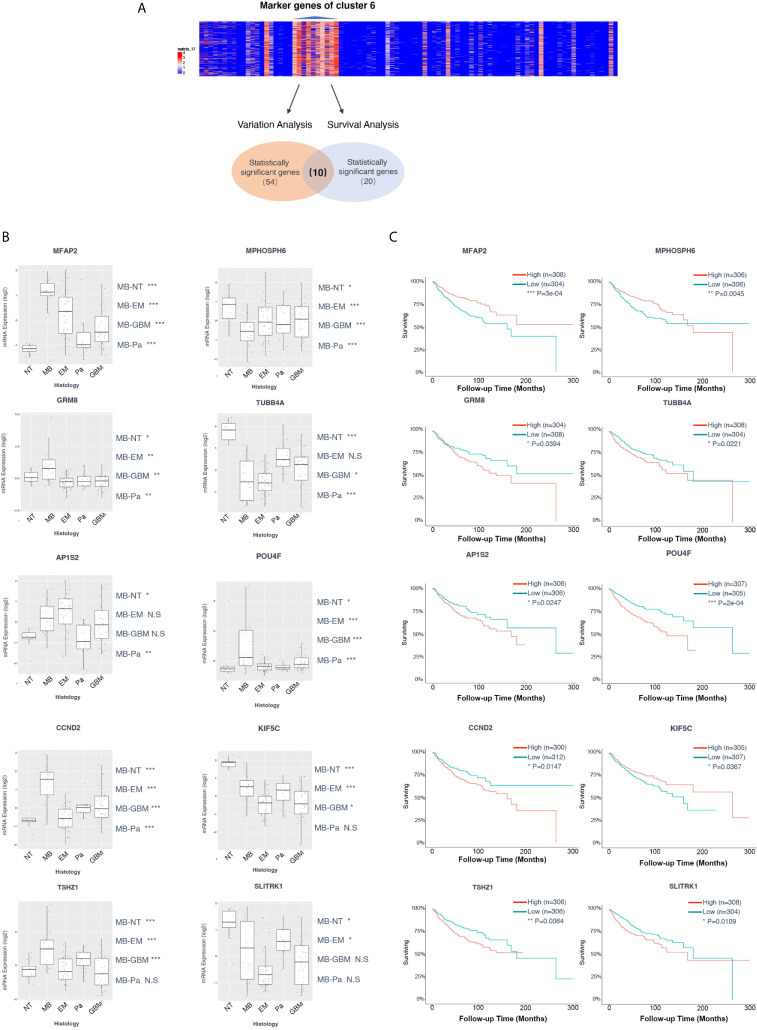

(A) Diagram of the screen process of Kaplan-Meier survival and variation analyses for the marker genes of cluster 6 with two cohorts of microarray data. Fifty-four genes showed specific upregulation in one tumor type or normal brain. Twenty genes exhibited correlation with the survival of patients with medulloblastoma (MB). Ten genes contained significant differences of either expression or survival analysis, including TUBB4A, TSHZ1, SLITRK1, POU4F1, MPHOSPH6, MFAP2, KIF5C, GRM8, CCND2, and AP1S2. (B) Box plot of variant analysis of microarray data of the MB patient cohort grouped showing expression levels of TUBB4A, TSHZ1, SLITRK1, POU4F1, MPHOSPH6, MFAP2, KIF5C, GRM8, CCND2, and AP1S2 in various brain tumors and normal brain. NT, normal tissue; MB, medulloblastoma; EM, ependymoma; Pa, pilocytic astrocytoma; GBM, glioblastoma. (C) Kaplan-Meier survival curve of microarray data of the MB patient cohort grouped by TUBB4A, TSHZ1, SLITRK1, POU4F1, MPHOSPH6, MFAP2, KIF5C, GRM8, CCND2, and AP1S2 expression level. Data are mean ± s.e.m. *P ≤ 0.05; **P ≤ 0.01; ***P ≤ 0.001; ****P < 0.0001; NS, not significant (P > 0.05).